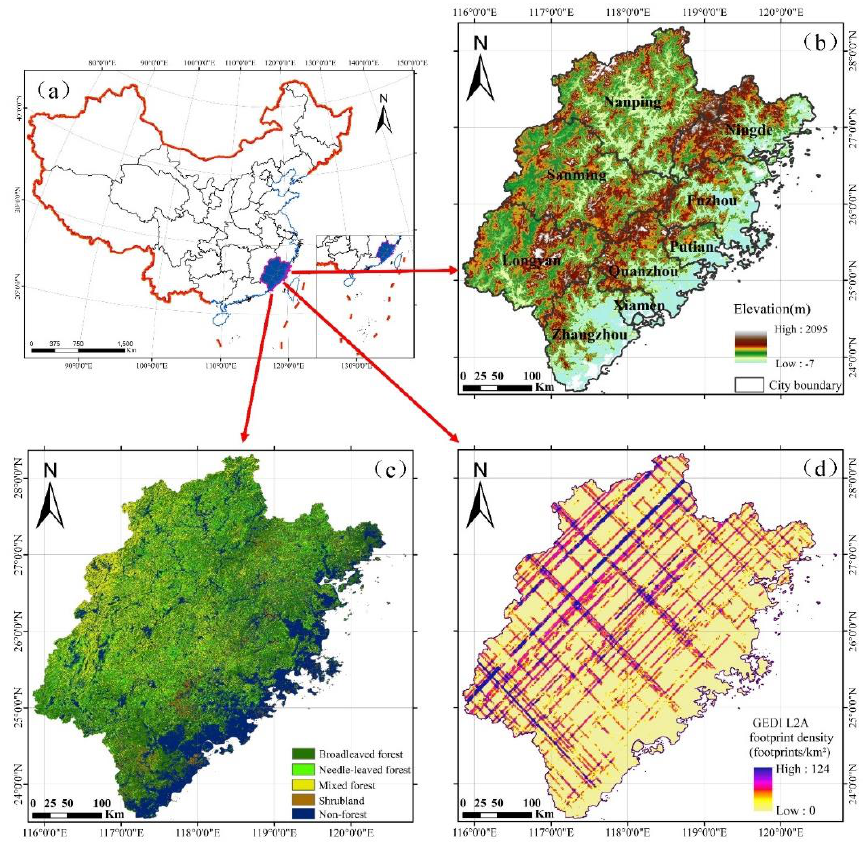
Figure 1. Study area. ( a ) The geographical location of Fujian, ( b ) a DEM of the study area, ( c ) forest types in the study area, and ( d ) a density distribution map of GEDI_2A footprint data in 1 km 2 of the study area.